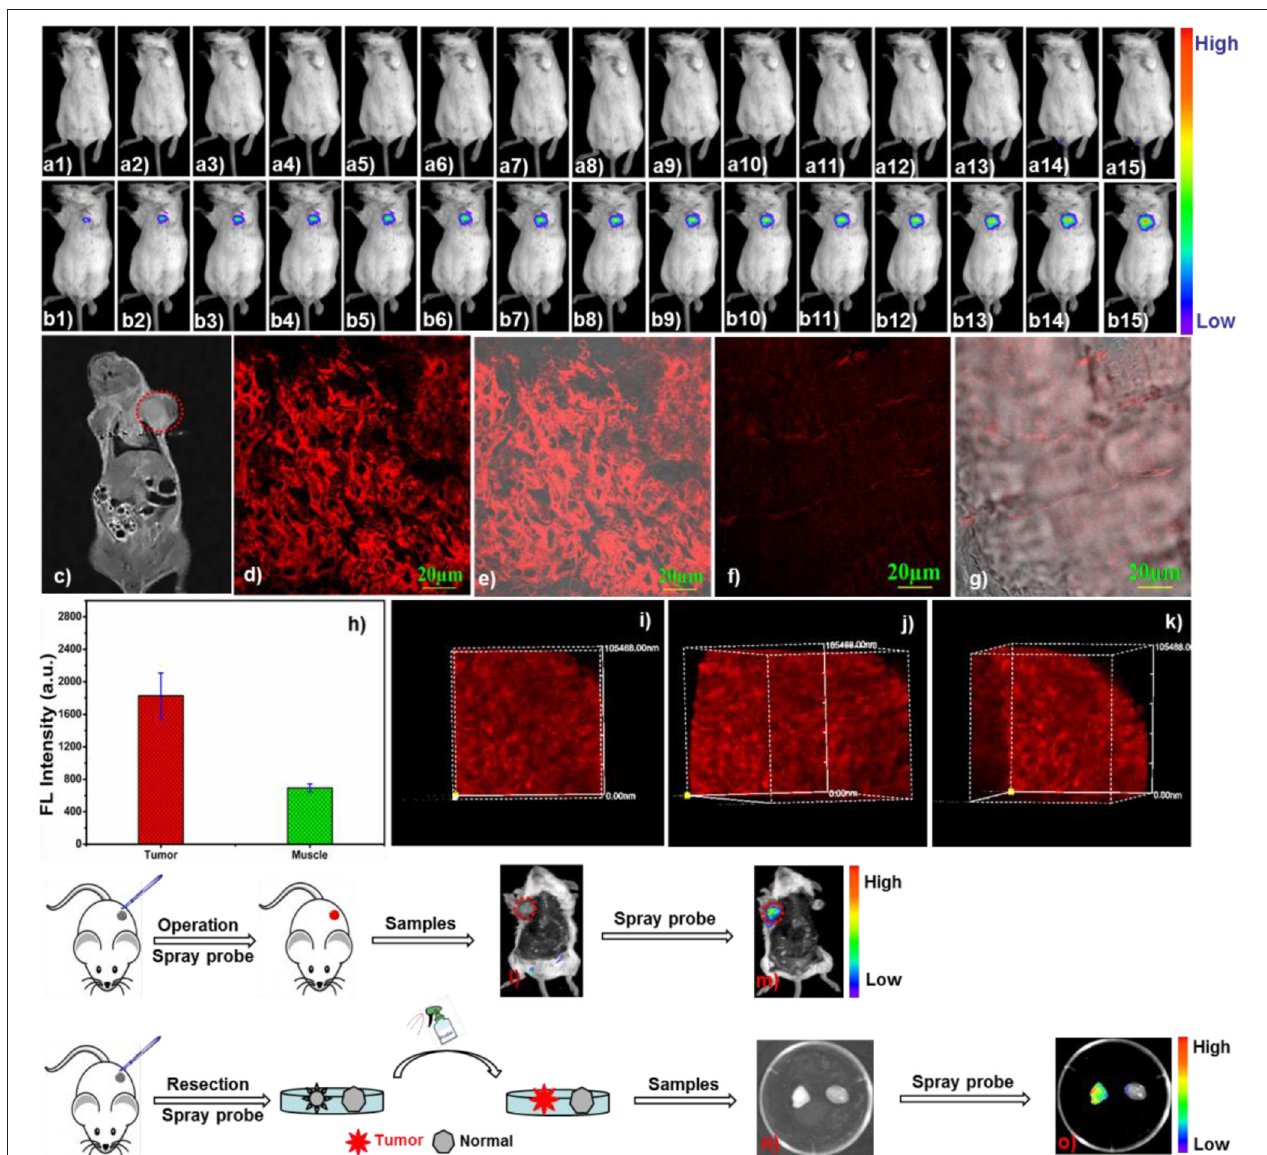
FIGURE 8 | (a,b) In vivo fluorescence imaging of γ -GGT activity in BABL/c mice bearing xenograft tumor. Probe NIR-SN-GGT (50 µ M, 100 µ L) was intratumoral injected, subsequently, fluorescent photographs (insert: b1) 2min; (b2) 5min; (b3) 10min; (b4) 15min; (b5) 20min; (b6) 25min; (b7) 30min; (b8) 40min; (b9) 50min; (b10) 60min; (b11) 70min; b12 80min; b13) 90min; (b14) 100min; (b15) 120min) were gathered with excitation at 475nm (fwhm 20nm) and emission at 655nm (fwhm 20nm). (a1–a15) the corresponding control group was injected equivalent PBS buffer (pH 7.4, 0.01M) solution. (c) MRI imaging (MesoMR23-060H-I) via T2 weighted imaging (red dotted line represents the tumor). (d–g) Tissue imaging of tumor tissue ( d -fluorescence channel, e -merged channel) and normal ( f -fluorescence channel, g -merged channel) pre-incubated with 10 µ M probe NIR-SN-GGT in PBS buffer solution, and washed thirce by PBS buffer. (h) The fluorescence intensities of tumor and normal were gathered as averages of 21 regions of interest (ROIs) from NIR channel. (i–k) 3D-depth imaging (500 µ m) of tumor tissue under the two-photon excitation at 800nm. Fluorescence imaging of mouse (before l ) and after (m) was sprayed with probe NIR-SN-GGT (100 µ M, 150 µ L). Fluorescence imaging of tumor tissue (left side) and normal tissue (right side) via “spraying” style ( n : bright image; o : fluorescence image). λ ex = 488nm, λ em = 655–755nm. Scale bar = 20 µ m.